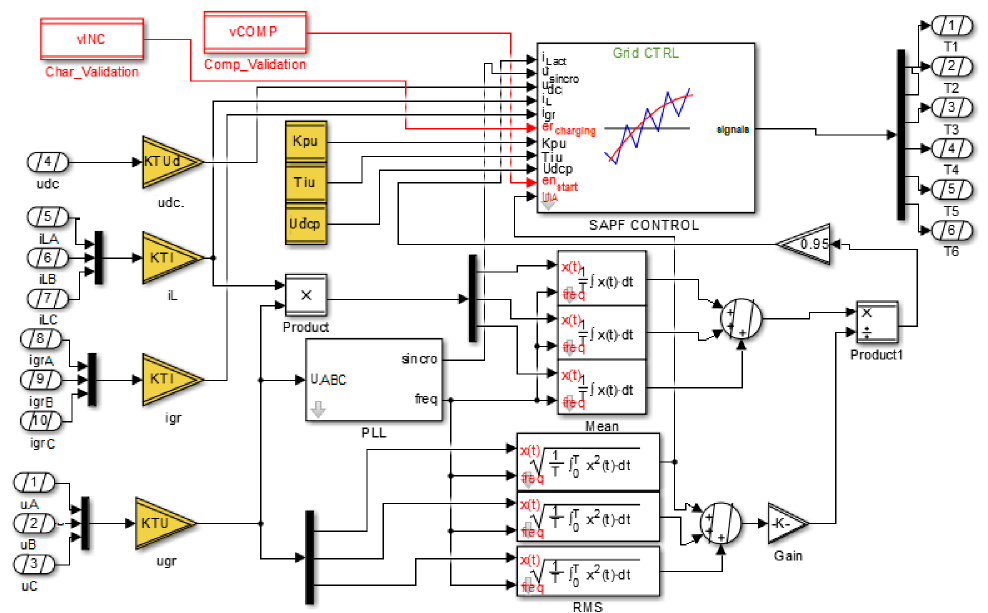
Figure 10. The scheme of the control algorithm implemented on the DS1103 PPC Controller Board. The original method adopted for the indirect current control involves the control of the grid current by prescribing the total active current ( i ∗ ), which is obtained as the gr sum of two components (the current corresponding to the losses in SAPF ( i aloss ) and the load-balanced active current ( i aL ). The two components of the current, on each phase, are obtained by multiplying the corresponding magnitudes with the “sincro” signal. The magnitude of the current related to losses ( I alossM ) is obtained from the output of the capacitor voltage controller (y_Ruc), transformed into amps (Figure 11). A detailed description of the blocks in Figure 11 can be found in [44].